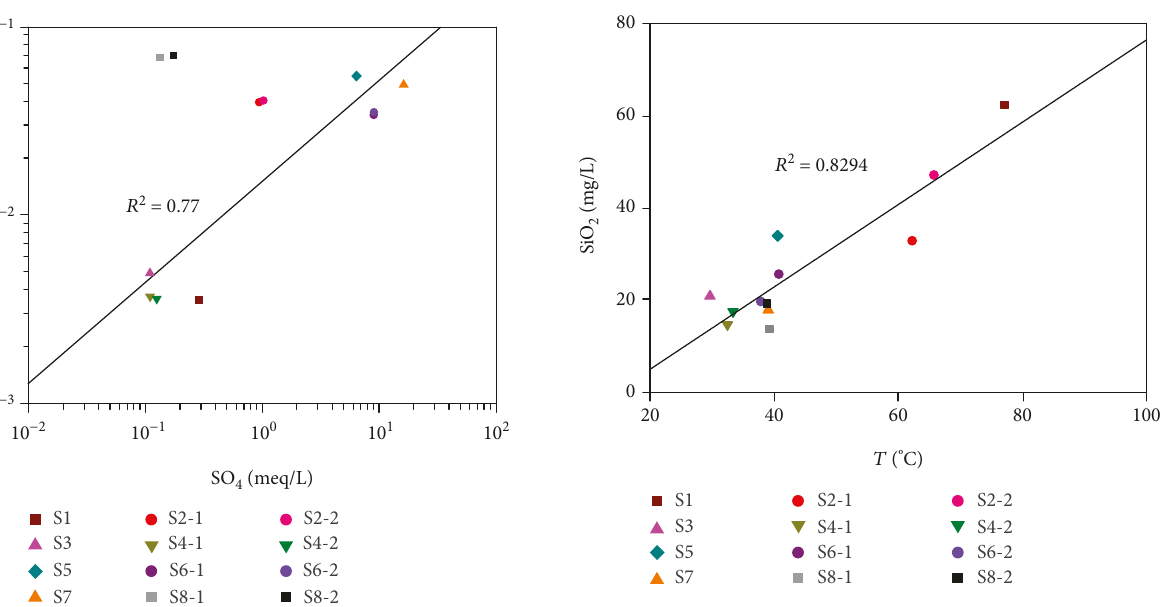
Figure 7: Relationship of Sr and SO Simao Basin.